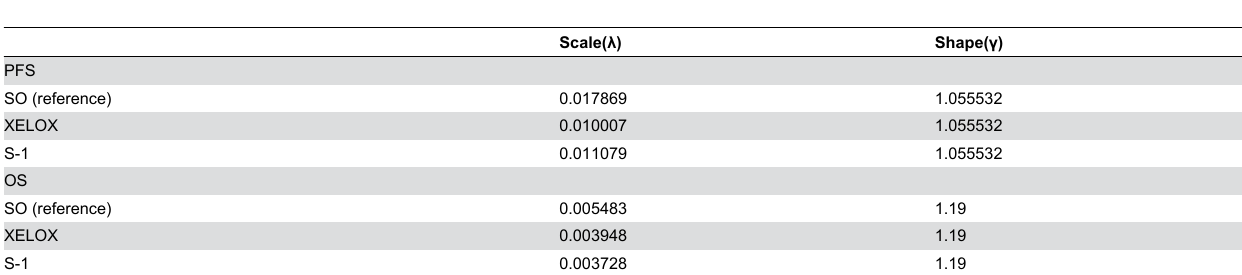
Table 3. Weibull parameters for progress-free survival (PFS) and overall survival (OS) for three strategies.